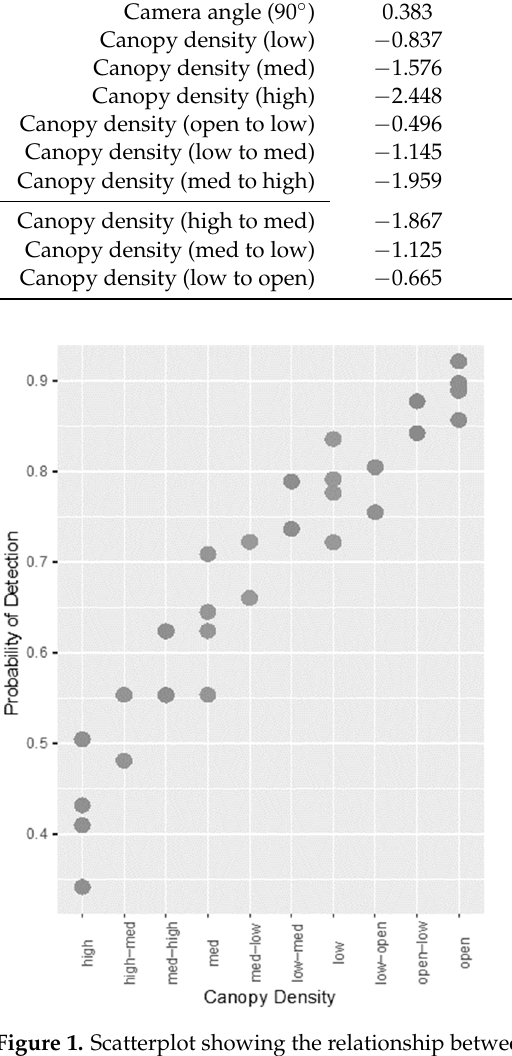
Table 3. The model with the best fit for RGB images with manual detection includes the variables camera angle and canopy density.